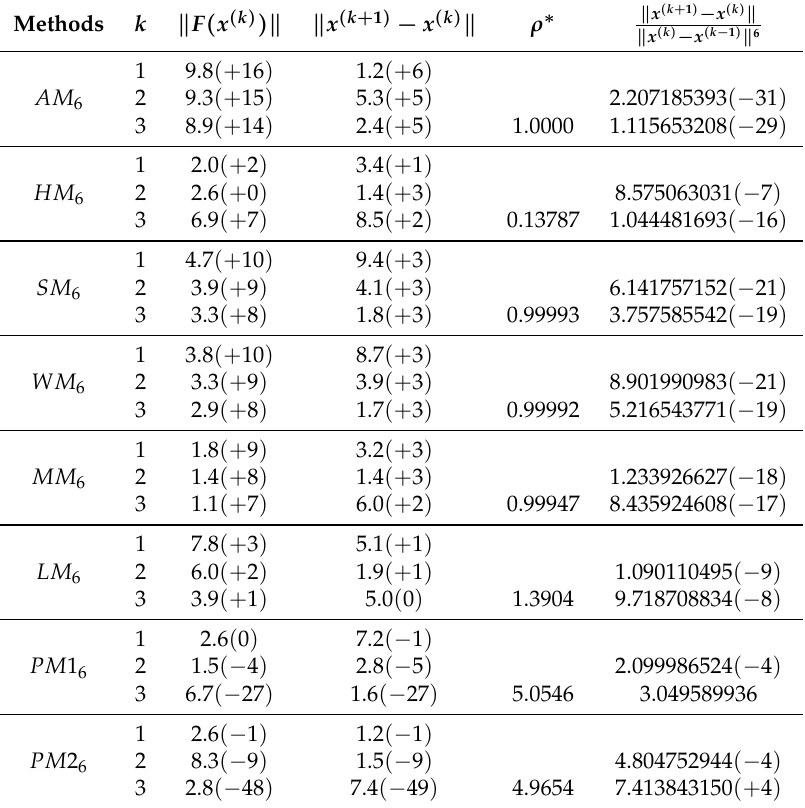
Table 3. Comparisons of methods on Van der Pol equation in Example